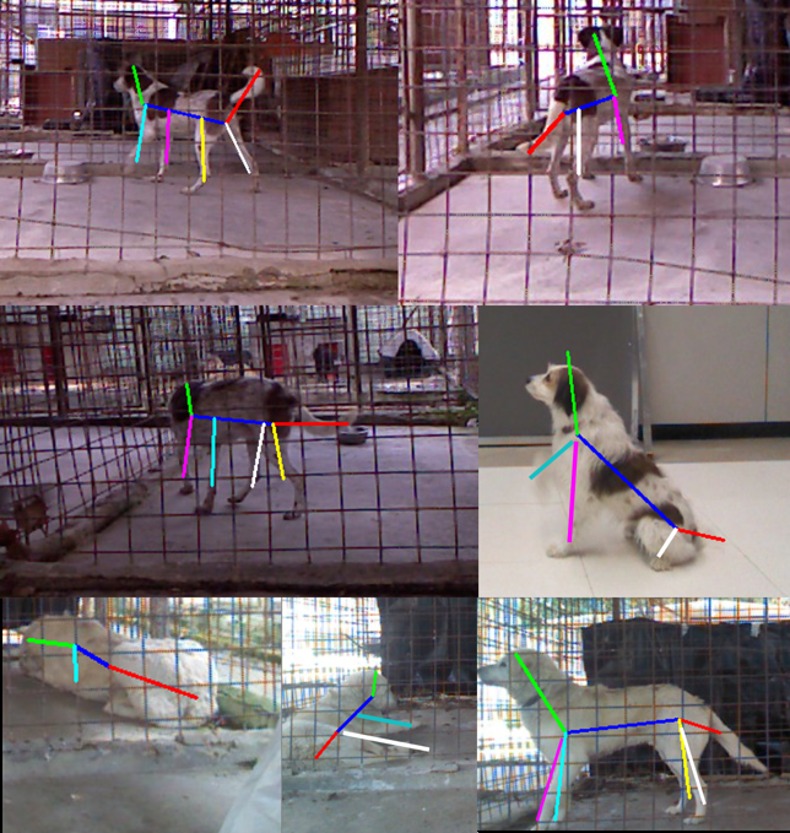
Qualitative Examples of Body part detection.Each image shows an example of the extracted dog body part in different conditions. Different line colours correspond to different body parts.